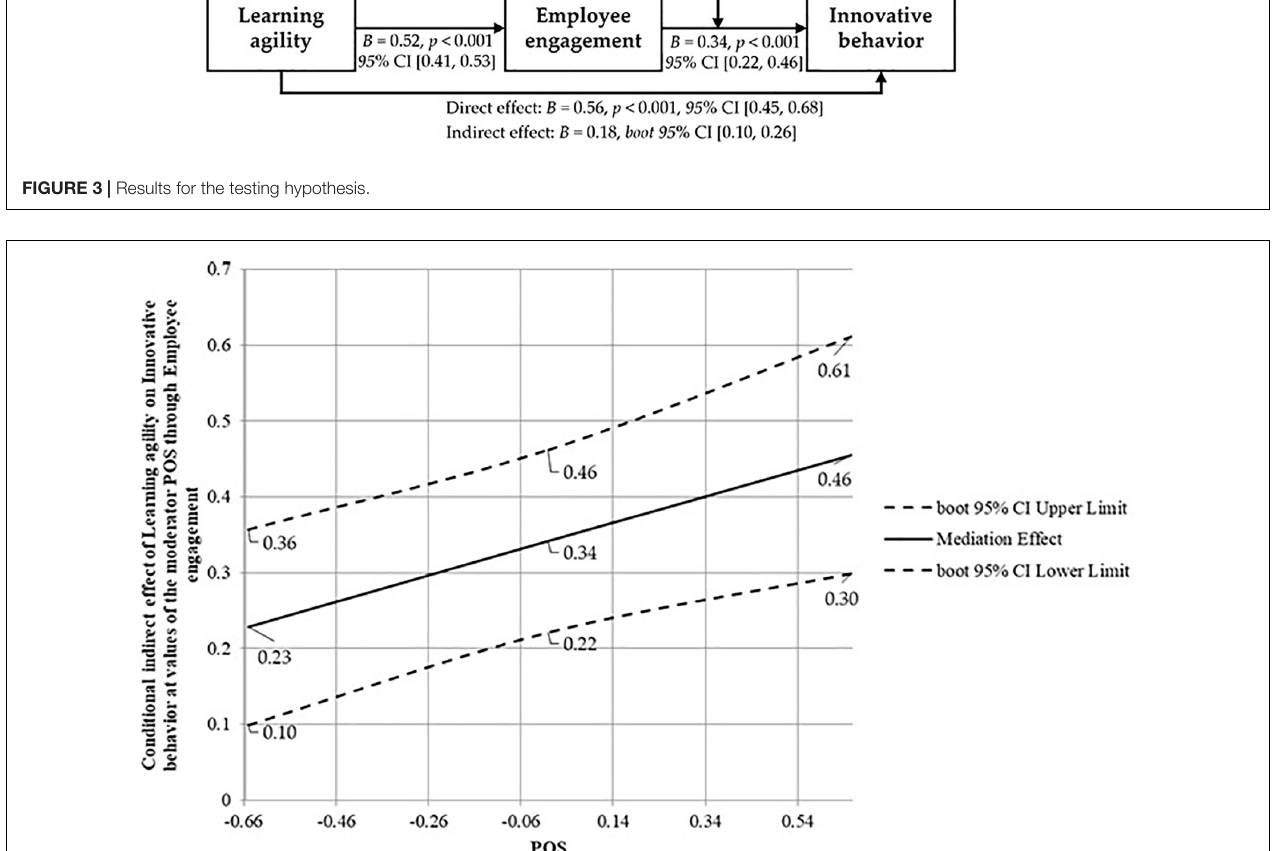
FIGURE 4 | Conditional mediation effects of learning agility on innovative behavior at values of the